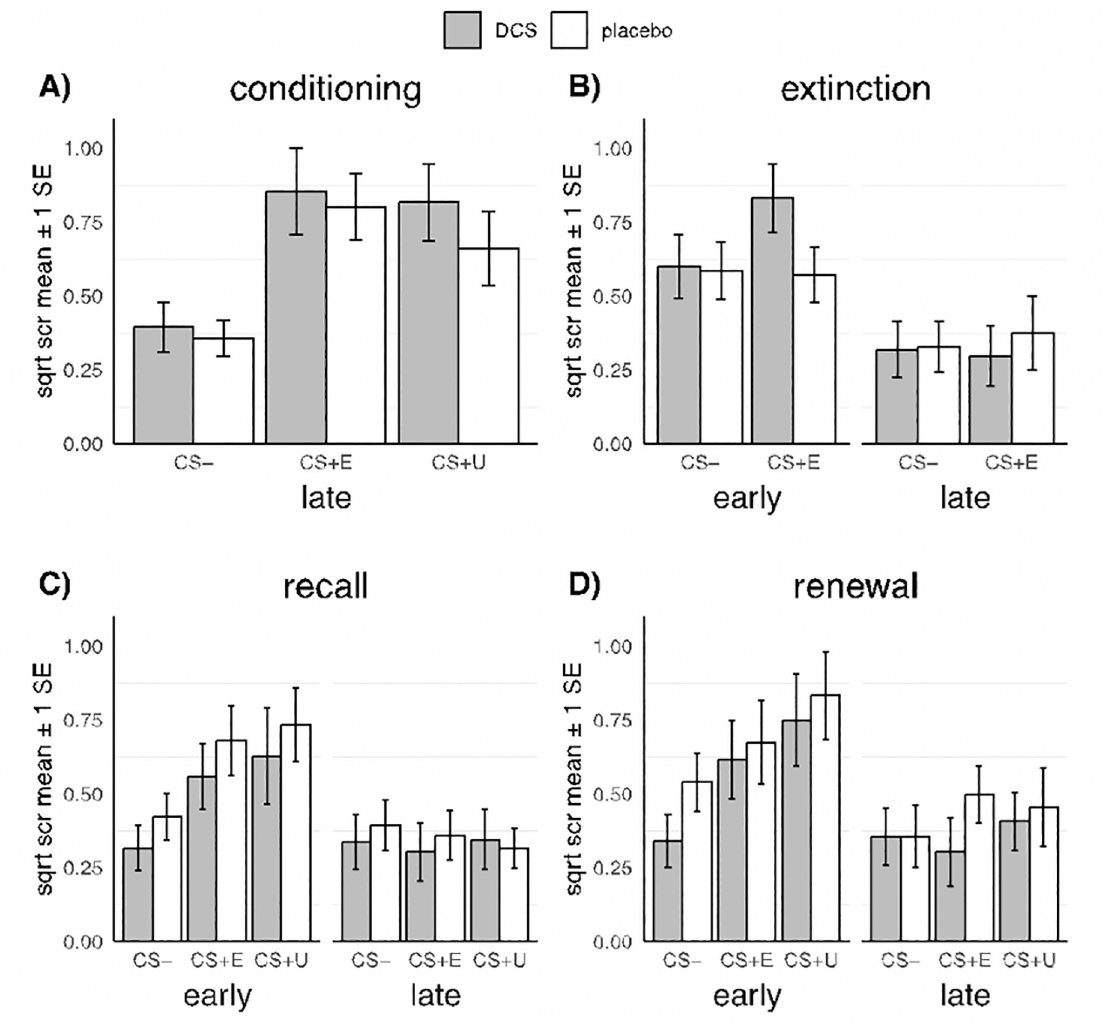
Fig 2. Conditioned skin conductance responses (SCR) across all phases of the experiment. Note. DCS was administered 1 hour prior to extinction. PBO = placebo group, DCS = d-cycloserine, SCR = skin conductance response, SE = 1 standard error, CS- = stimulus that was not paired with shock, CS+E = stimulus that was paired with shock during conditioning and presented in the extinction phase, CS+U = stimulus that was paired with shock during conditioning but not presented in the extinction